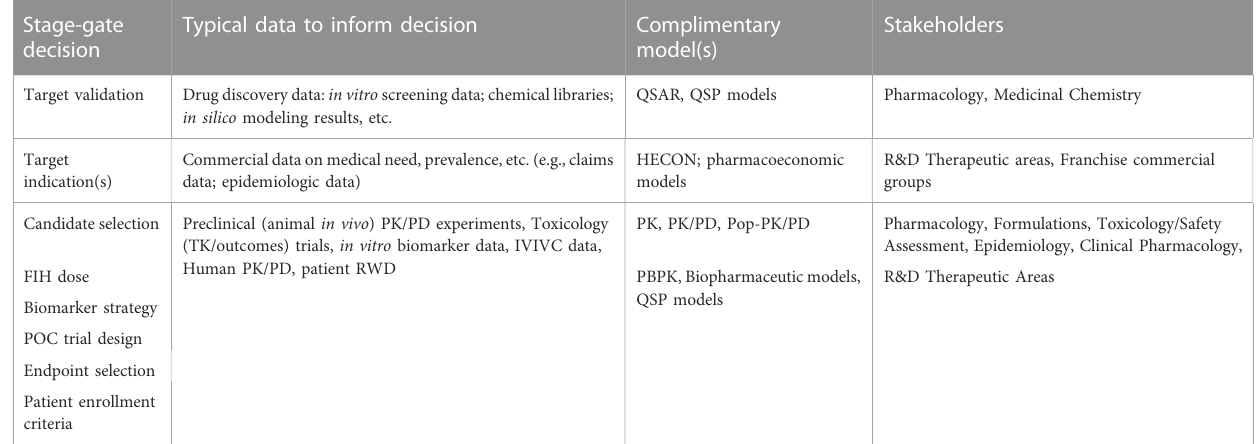
TABLE 1 Data, model and stage-gate decision connectivity in a traditional MIDD drug discovery